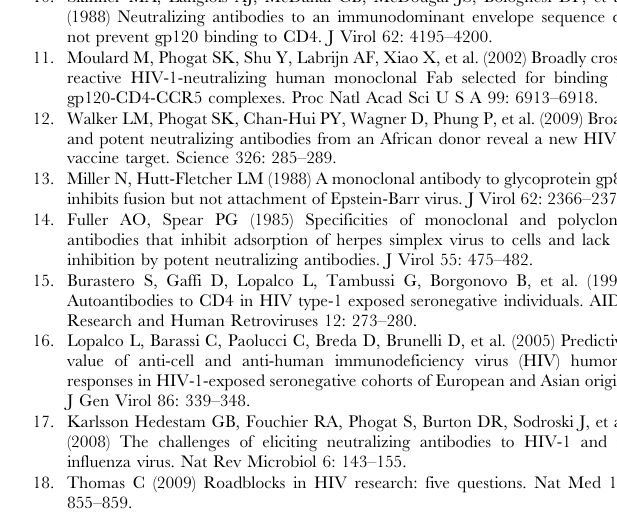
Figure S1 Local conformation of the putative DB81 epitope in the unliganded (green; accession code: 1WIP/MMDB 6042) and gp120-bound (purple; accession code: 1G9N/MMDB 14984) tridimensional structures of human CD4. The main chains are depicted in the cartoon representation with arrows denoting beta- strands; the insert shows the same region with the main chains depicted as lines and the side chains as sticks. Small but significant differences are seen in the positioning and length of the beta- strands, as well as in the spatial orientation of the lateral chains, which can justify the preferential reactivity of MAb DB81 with the gp120-liganded form of CD4. In baboon and macaque CD4, residues Leu162, Asn165 and Lys167 are substituted by Ser, Asp and Thr, respectively. Figure S2 Binding of MAb DB81 to solid phase CD4 or CD4- gp120 complexes. Binding of MAb DB81 to solid phase 2D-sCD4, either alone or in equimolar complex with different recombinant gp120 (from isolates Ba-L or IIIB) was measured by ELISA.